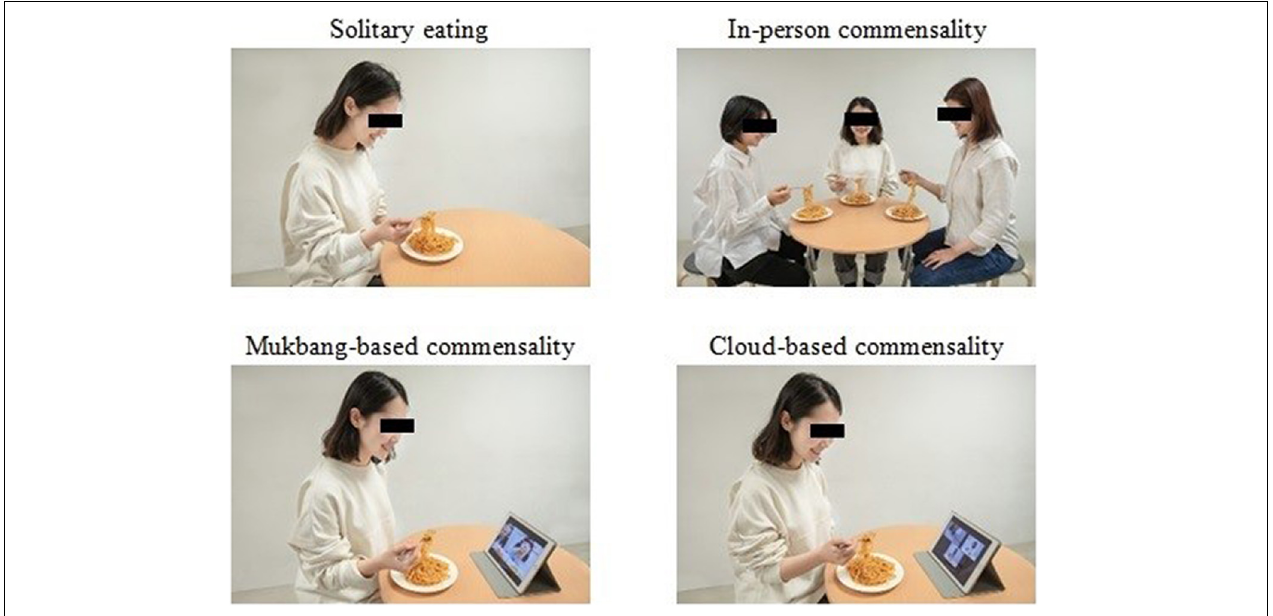
FIGURE 1 | Scenario photos of female diners. Note that we blocked the faces of the diners with black bars to protect their privacy, but the photos were presented to the participants without the black bars in the study.